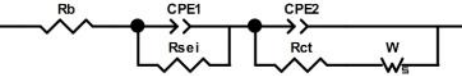
Table 2. Resistance parameters of R b , R sei and R ct obtained from simulation data. Half Cell ( c ) Figure 9. Scanning electron microscope (SEM) analysis before and after three cycles: ( a ) fresh NCM cathode electrode; ( b ) NCM cathode electrode cycled in baseline electrolyte; and ( c ) NCM cathode electrode cycled in safety electrolyte. 4. Conclusions The safety electrolyte that has been validated in our previous work shows good safety, thermal stability and conductivity. The effects of the safety electrolyte on NCM electrode were investigated in this work. It was found that the MC additive ( i.e. , VC, PS, and DMAC) only had an endothermic process in the thermal stability test, leading to the less heat generation of a fully charged NCM-safety electrolyte system, and a drastic reduction of the main exothermic peak value, which improved the thermal stability of the NCM LIB. In the electrochemical performance tests, NCM/safety electrolyte/Li half cells exhibited more stable cycle efficiency and good specific capacity retention, and CV results indicated that the safety electrolyte had good stability and compatibility with NCM. The results of AC impedance and SEM images show that the R sei value of NCM/safety electrolyte/Li half cells was